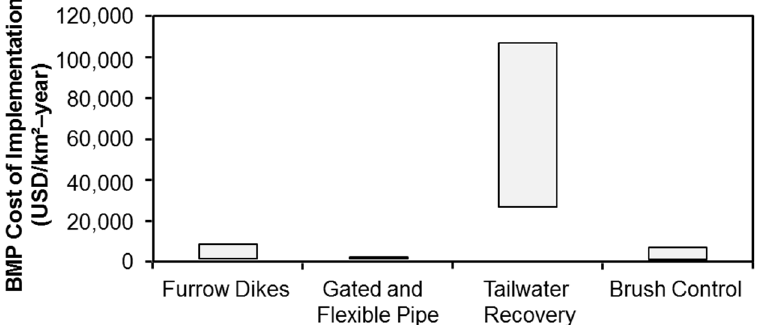
Figure 8. These four irrigation efficiency methods vary in cost of implementation with costs ranging from $1,500/km 2 ·year for gated and flexible pipe to over $100,000/km 2 ·year for the more expensive tailwater recovery systems. (Source data: [37]).